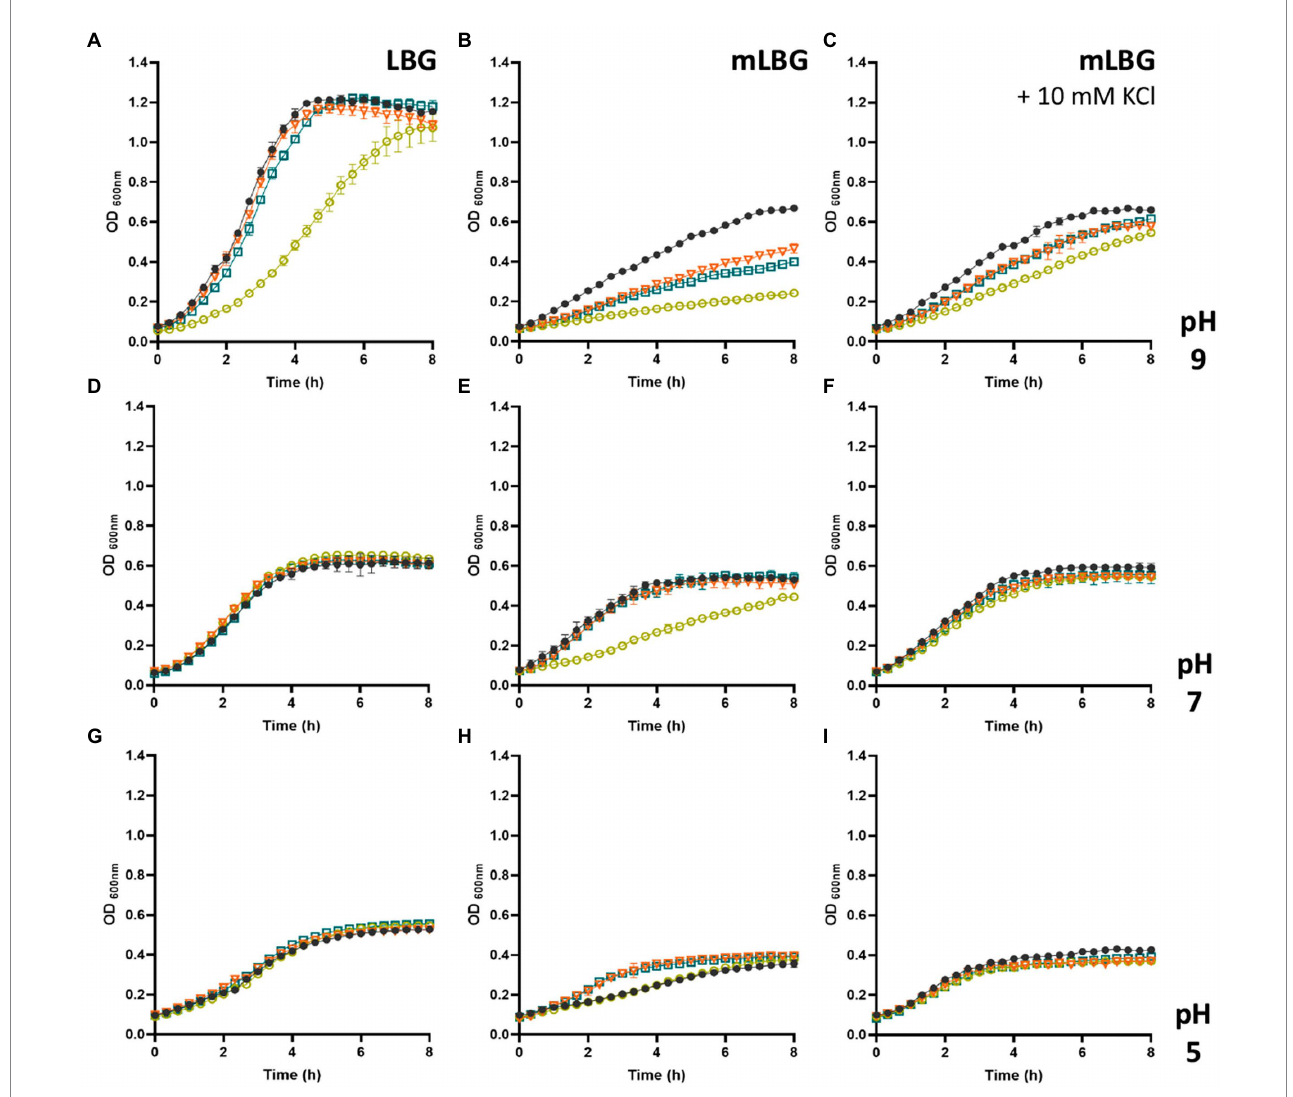
FIGURE 3 Growth curves of Enterococcus faecalis JH2-2 mutants under different conditions. Wild type (black dot), Δ ktrA (light blue square), Δ kup Δ ktrA (yellow circle), and Δ ktimA Δ ktrA (orange triangle) strains were grown in LBG (A,D,G) , mLBG (B,E,H) , or mLGB medium supplemented with 10 mM KCl (C,F,I) . Initial pH was fixed at 9.0 units (A–C) , 7.0 (D–F) , or 5.0 (G–I)